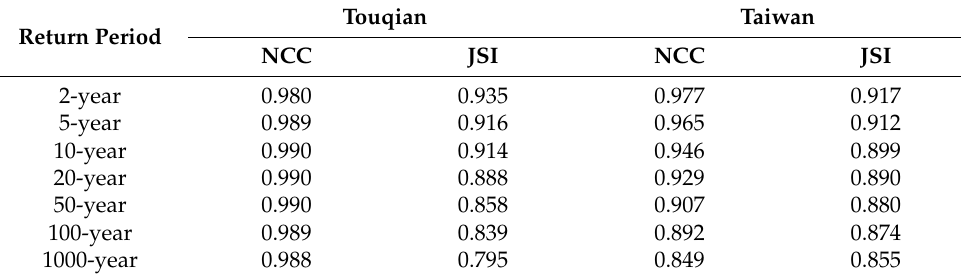
Figure 12. Similarity index for Touqian and Taiwan. Table 3. Similarity index between grid ‐ based and regional frequency analysis for Touqian water ‐ Table 3. Similarity index between grid-based and regional frequency analysis for Touqian watershed shed and Taiwan. and